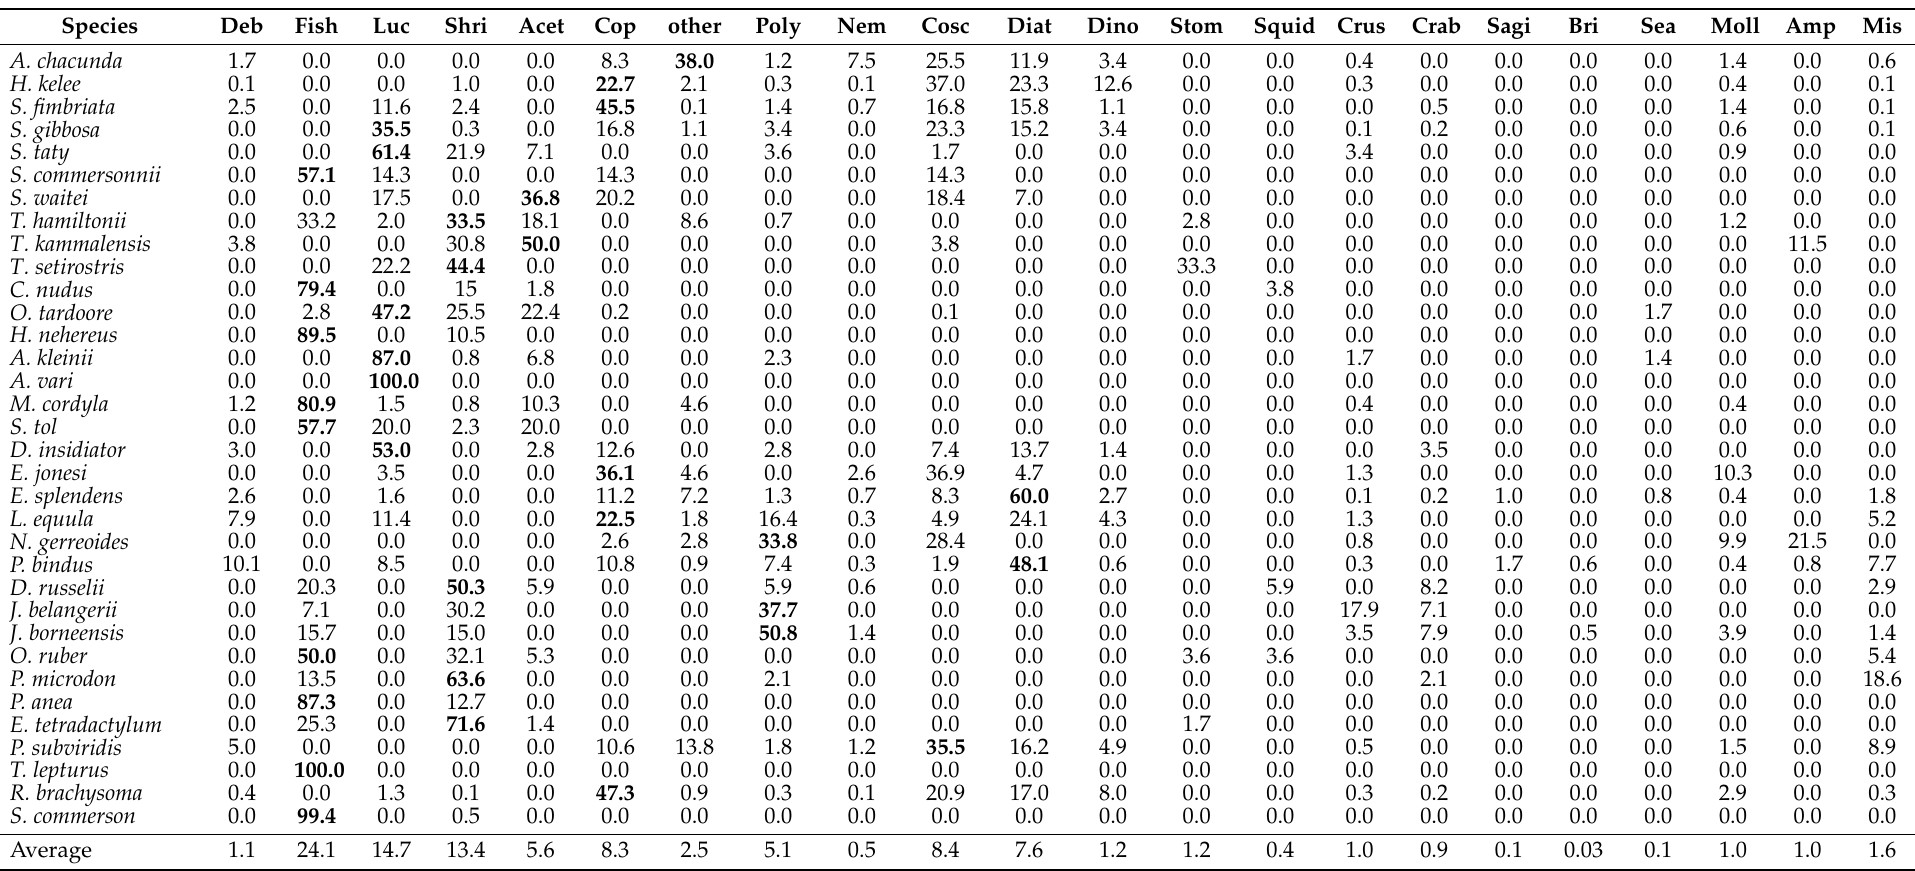
Table 2. Index of relative importance (%IRI) contribution of anthropogenic debris and other dietary types of fishes inhabiting the natural bay environment (Deb = anthropogenic debris; Fish = fish; Luc = Lucifer sp.; Shri = shrimp; Ace = Acetes sp.; Cop = copepods; other = other zooplankton; Poly = polychaetes; Cosc = Coscinodiscus sp.; Diat = other diatoms, Dino = dinoflagellates; Stom = stomatopods; Squid = squid; Cru = other crustaceans excluding copepods; Crab =